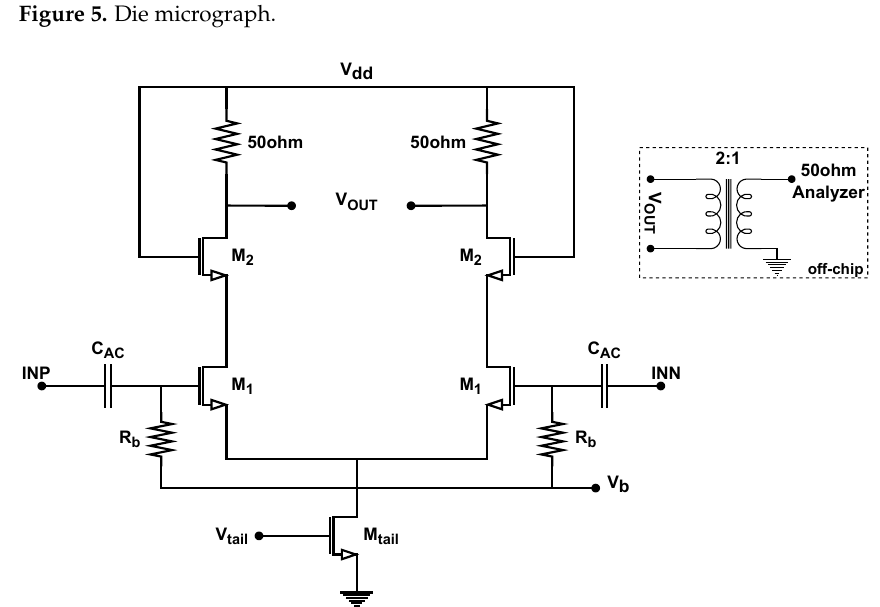
Figure 6. The CML buffer circuit used to drive the measurement equipment in a matched